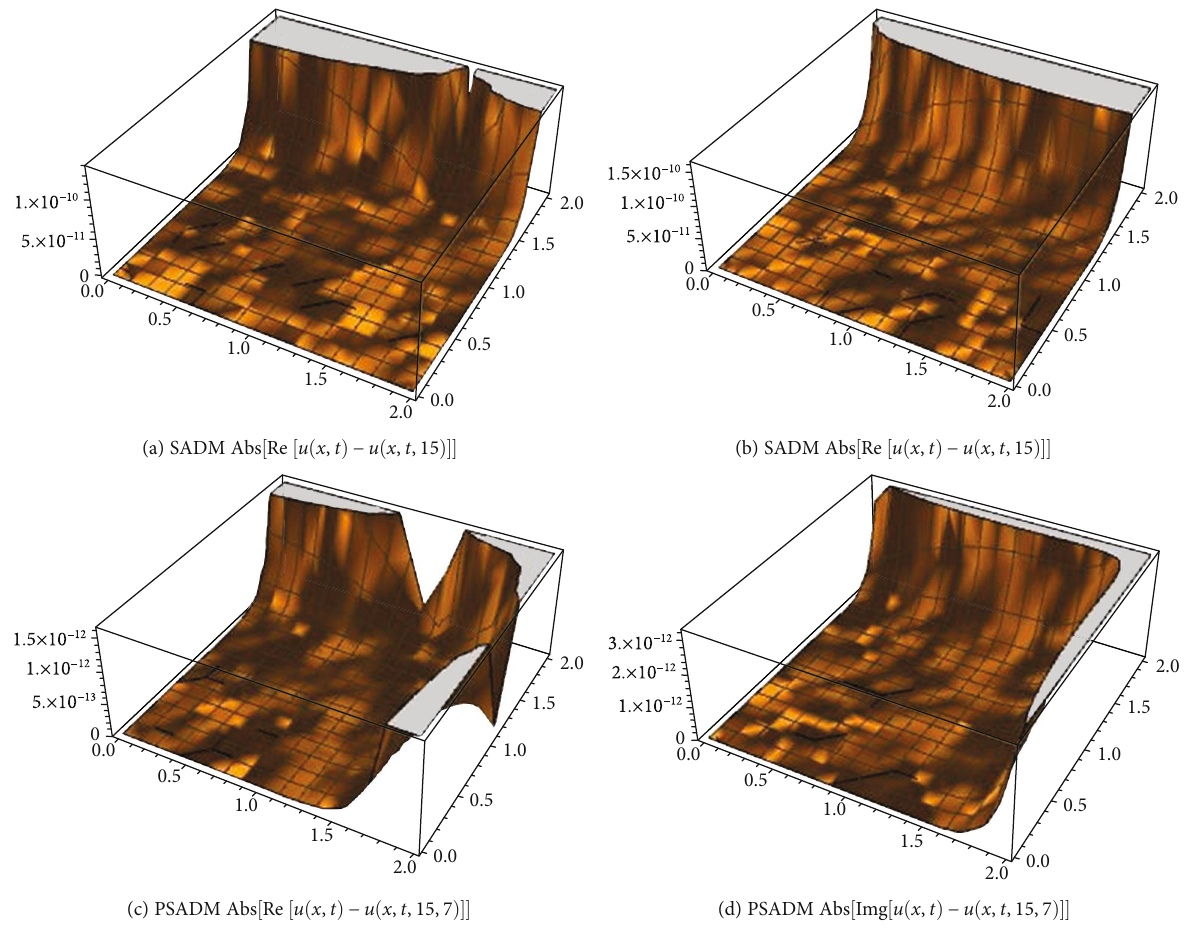
Figure 3: Absolute